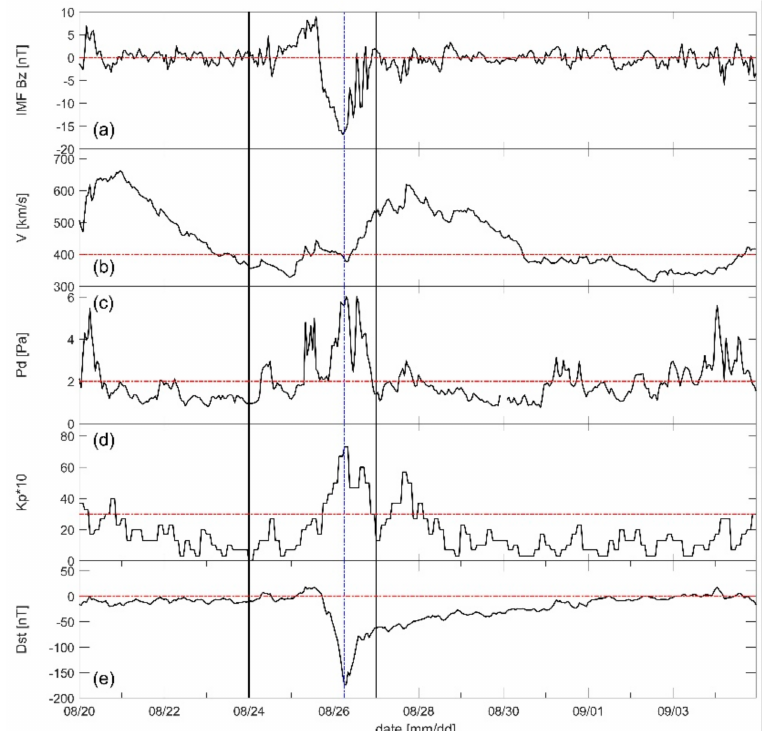
Figure 1. The variation of solar wind conditions and geomagnetic Dst and Kp indices from 20 August to 4 September 2018. From top to bottom: ( a ) the z component of the interplanetary magnetic field in the geocentric solar magnetospheric (GSM) coordinate system (interplanetary magnetic field (IMF) Bz ), ( b ) solar wind velocity, ( c ) solar dynamic pressure, ( d ) geomagnetic activity Kp index, and ( e ) Dst